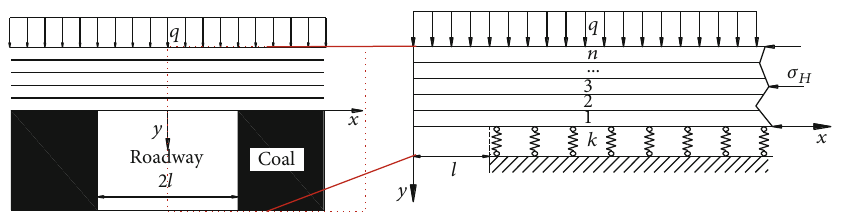
Figure 1: Analysis model of layered roof strata in coal roadway.